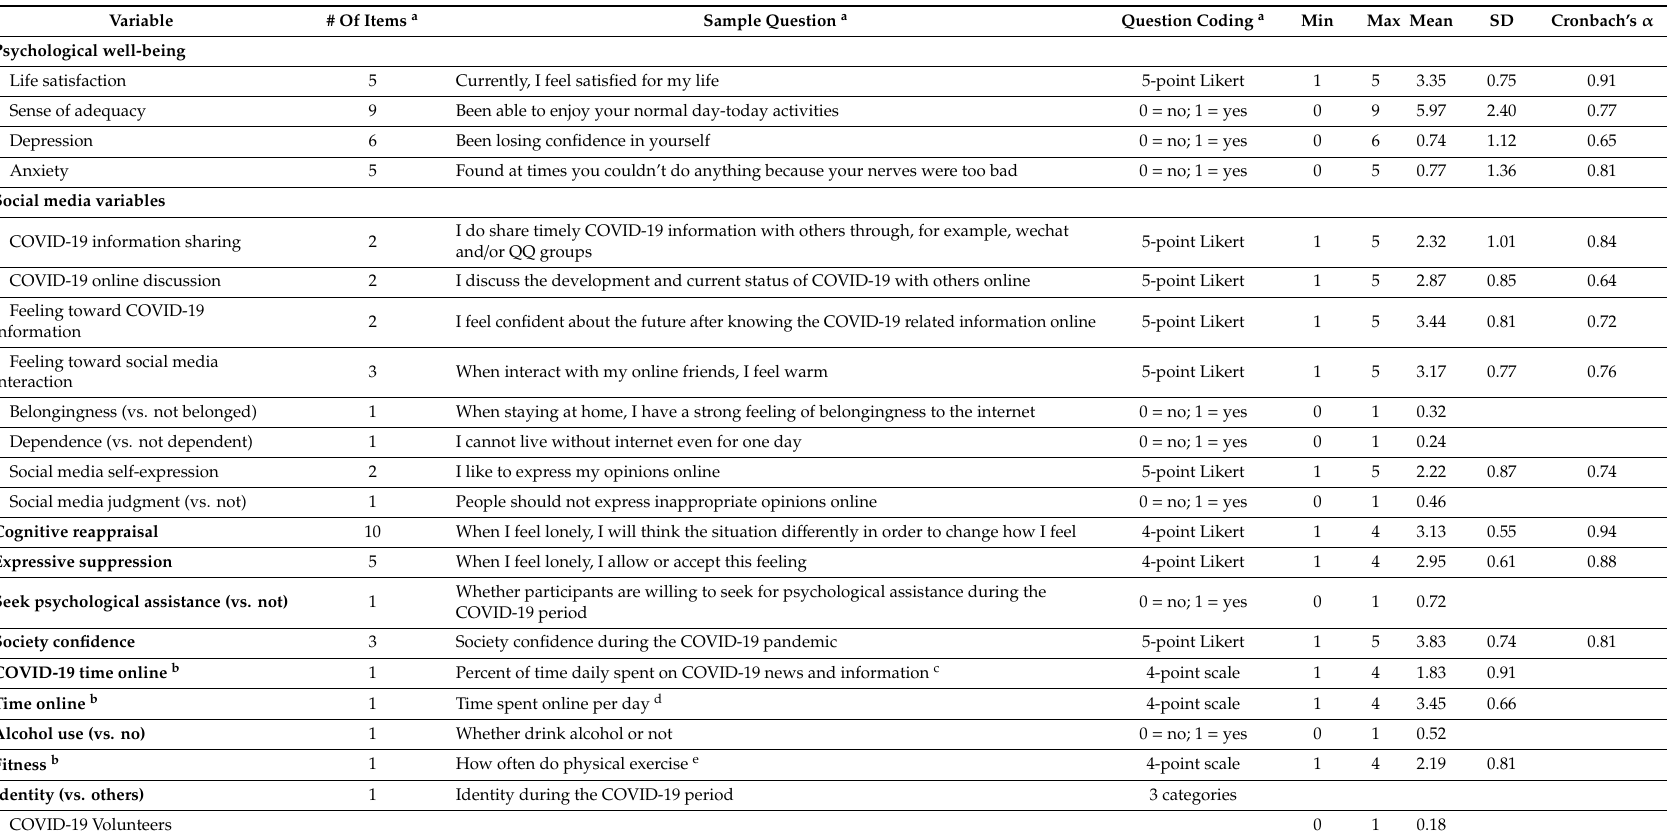
Table A1. Sample and variable